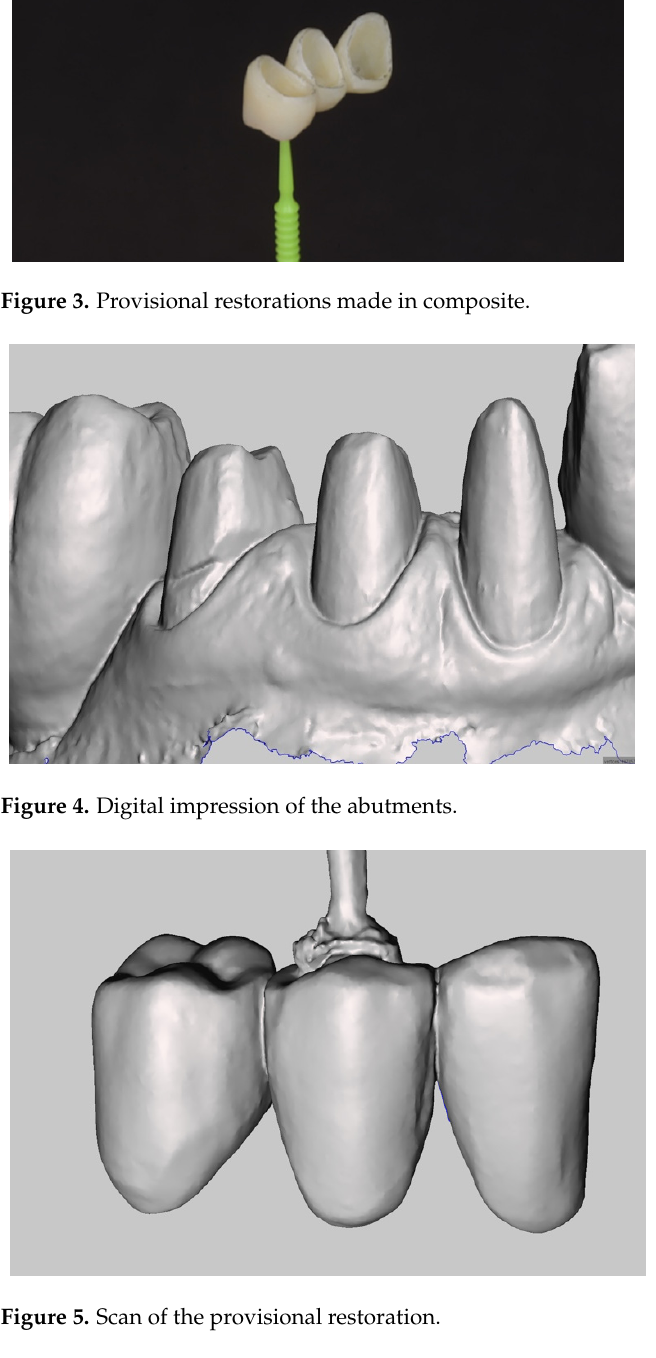
Figure 5. Scan of the provisional restoration.